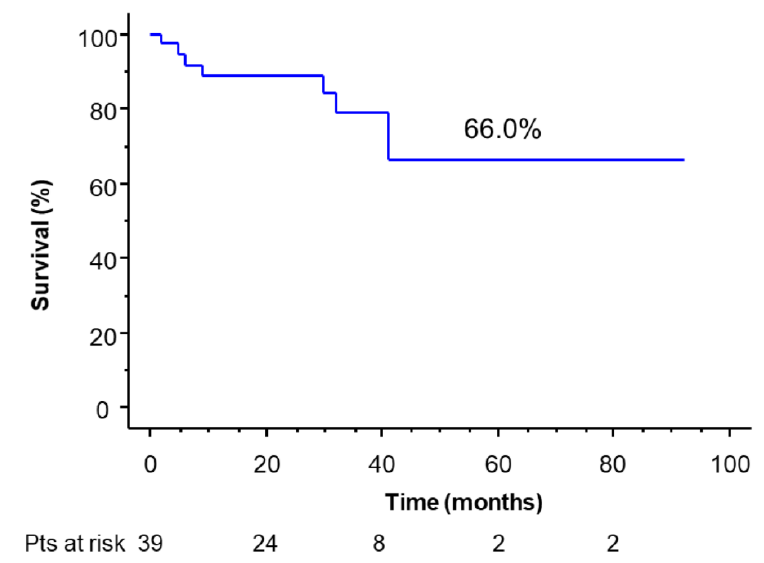
Figure 3. Overall survival of the operated